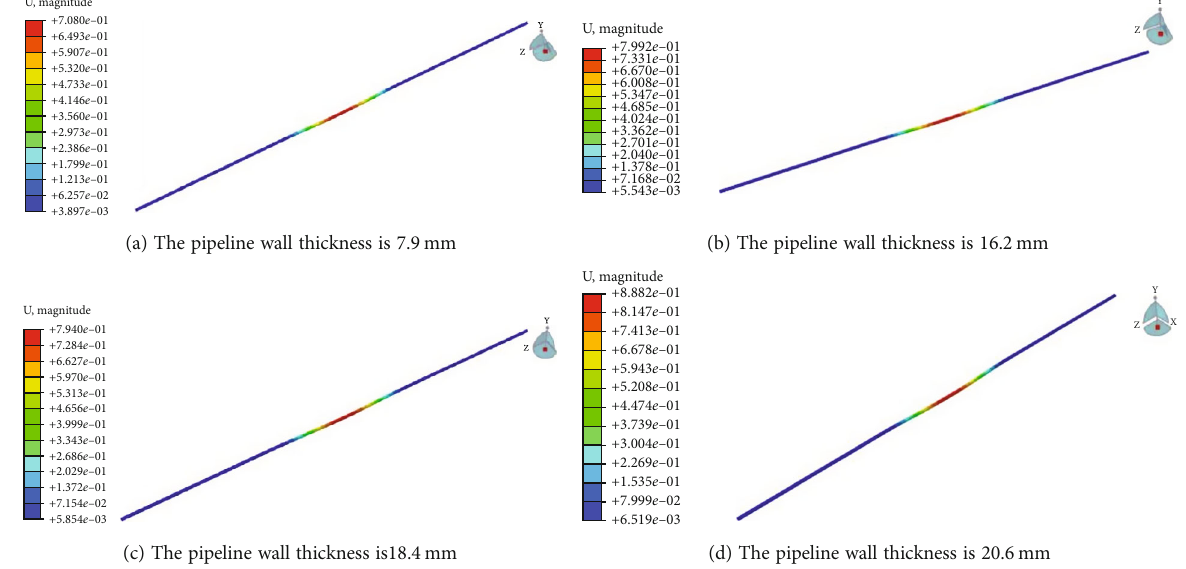
Figure 15: The pipeline ultimate deformation under di ff erent pipeline wall thicknesses.